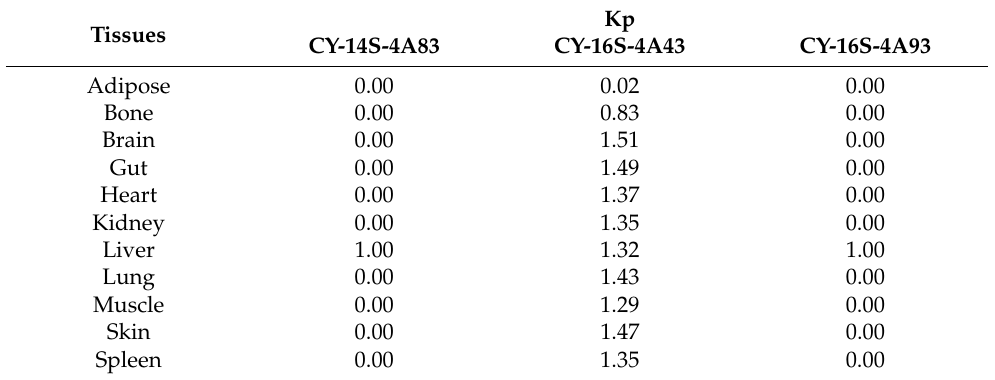
Table 7. Predicted distribution of CY-14S-4A83, CY-16S-4A43, and CY-16S-4A93 in tissues of